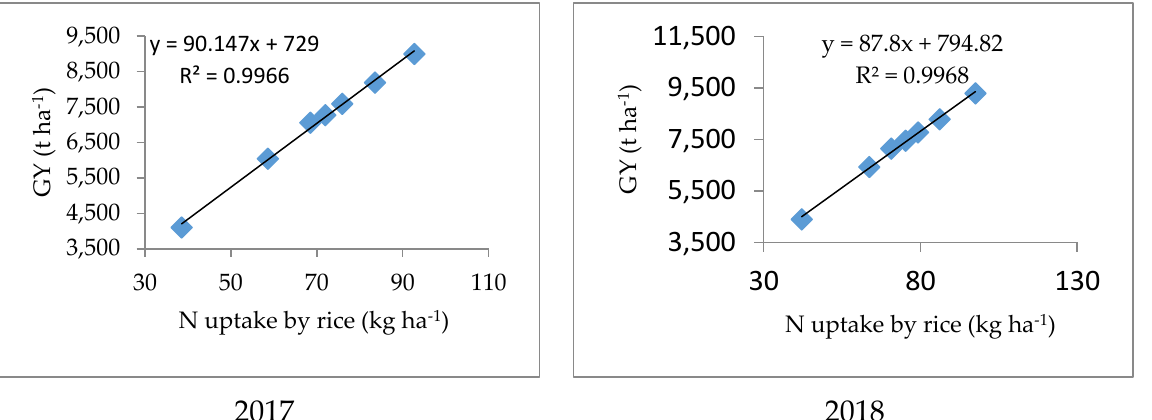
Figure 7. Linear regression line among weed management practices between dry matter accumulation vs. Grain yield (GY).